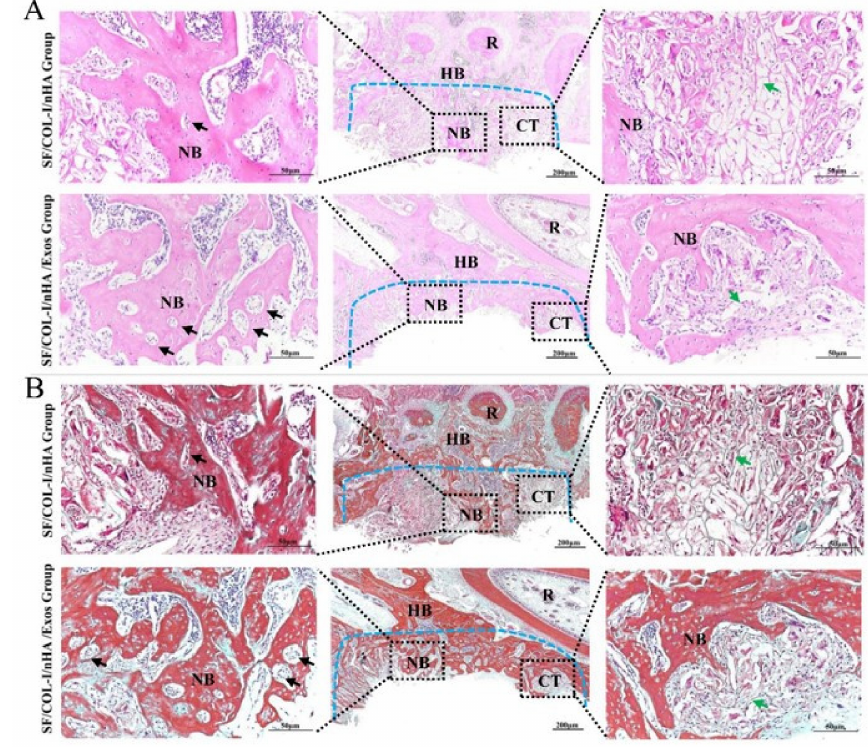
Figure 4. Histological results of bone regeneration at 6 weeks. ( A ) HE staining. ( B ) Masson staining. The blue dotted line means the dividing line between new bone and host bone. Black arrows indicate neovessels in the new bone. Green arrows represent the remaining SF/COL-I/nHA scaffold. NB: new bone; HB: host bone; CT: connective tissue; R: